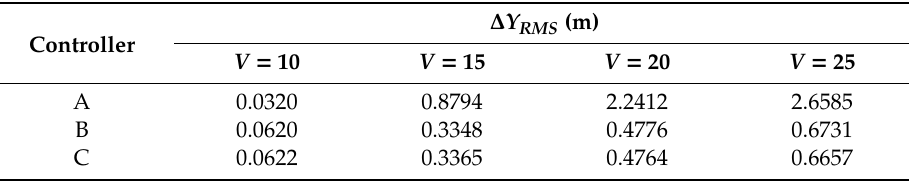
Table 6. Lateral deviations of 3 controllers at different vehicle velocities V (m/s).